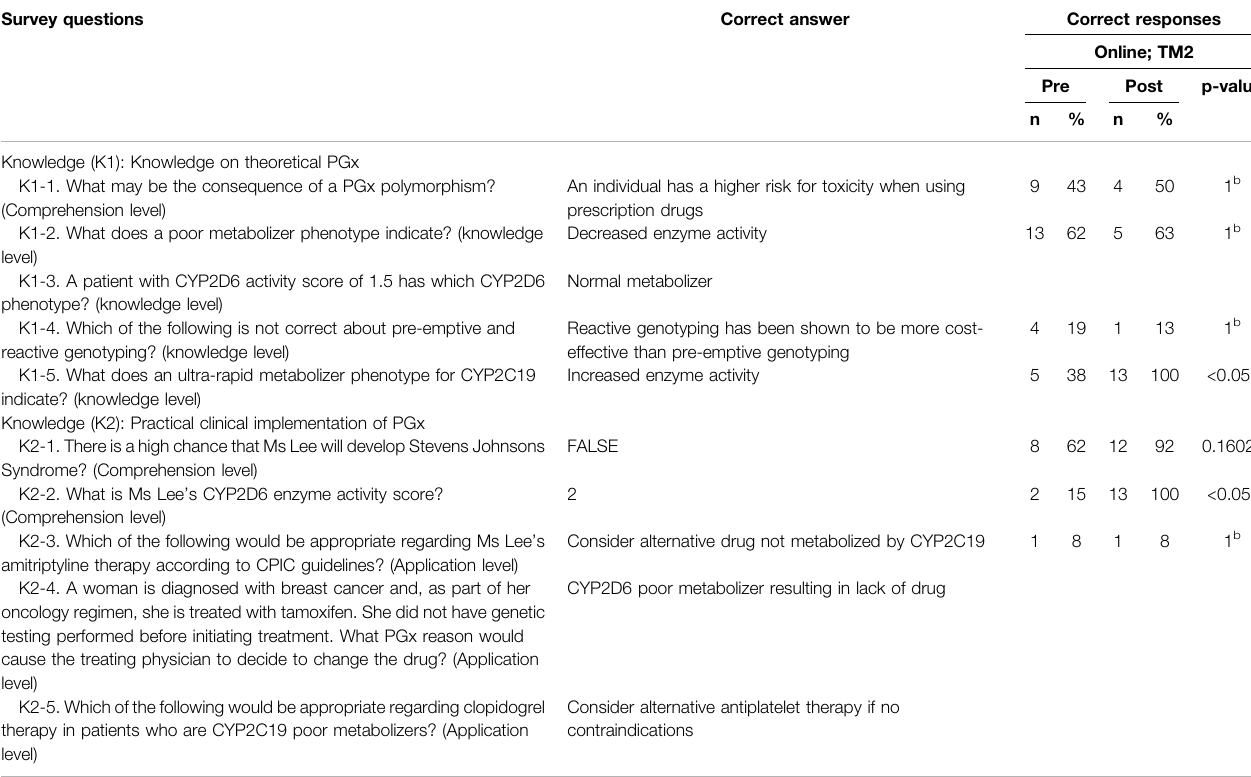
TABLE 6 | Correct responses to questions about knowledge on PGx comparing pre- and post-online training for TM2. Survey